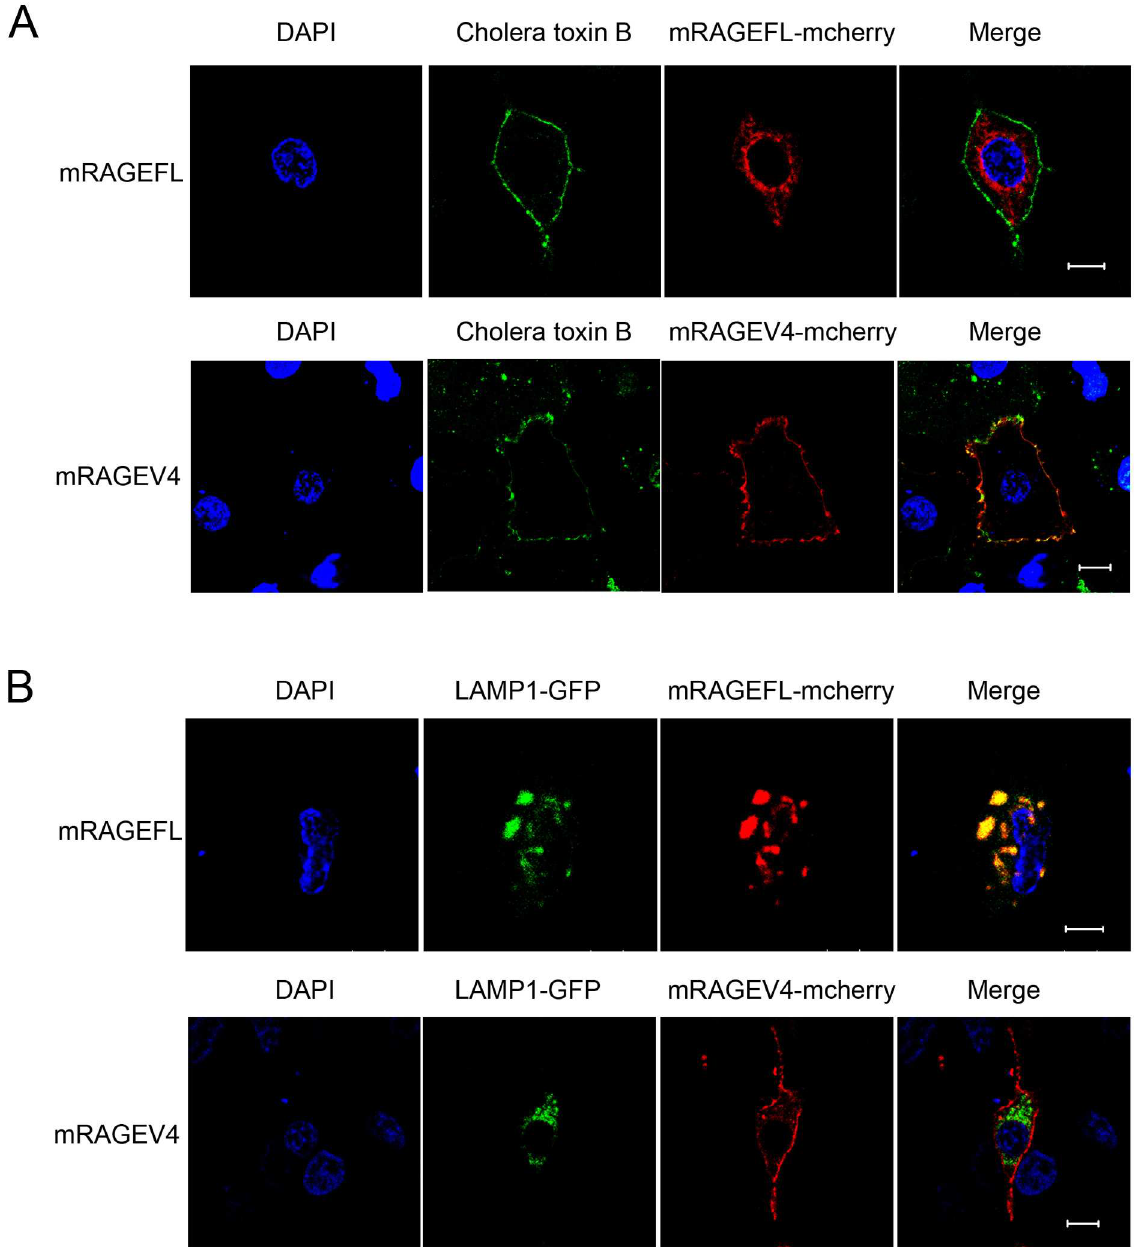
Fig 6. Examinationof cellularlocalization of mRAGEFL and mRAGEV4 in serum-starvedA549 cells. A549 cells were serum- starvedfor 6 h priorto transfection. (A) plasmamembranelocalization; (B) lysosomallocalization. Blue: DAPI (nucleus); red: mcherry(mRAGEFL and mRAGEV4); green:Alexa Fluor 488-conjugated plasmamembrane markercholera toxin B (A), and GFP- tagged lysosomemarkerLAMP-1(B). The scale bar represents10 μ